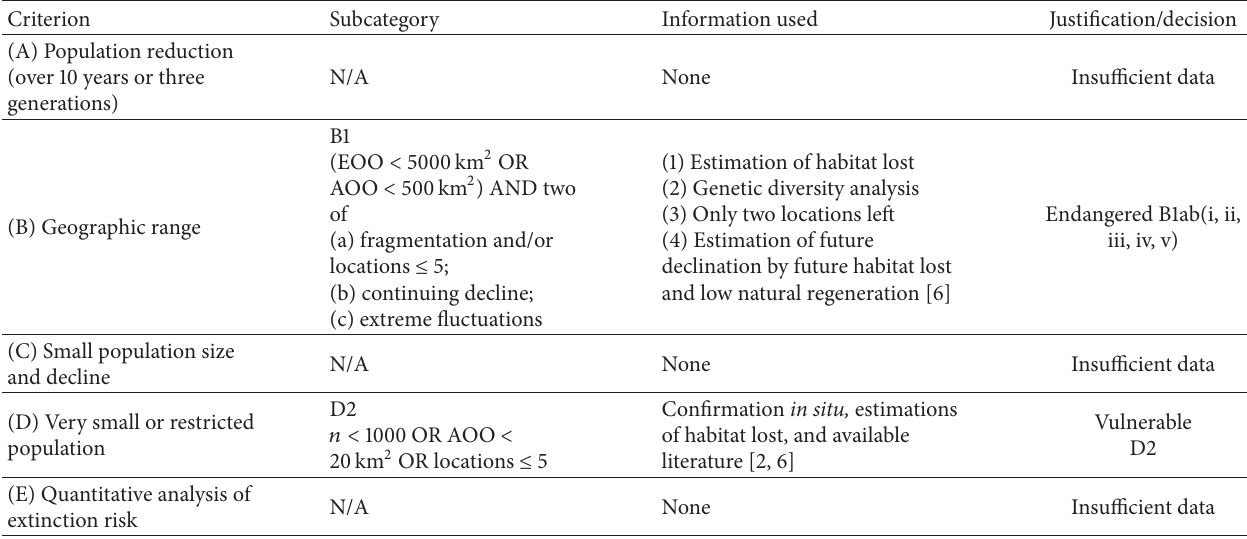
Table 4: IUCN Red List criteria that apply to P. splendens with description of the information used in the assessment and its applicability in the present study. EOO: extent of occurrence, AOO: area of occupancy, and 𝑛 : mature individuals (based on Cardoso et al.